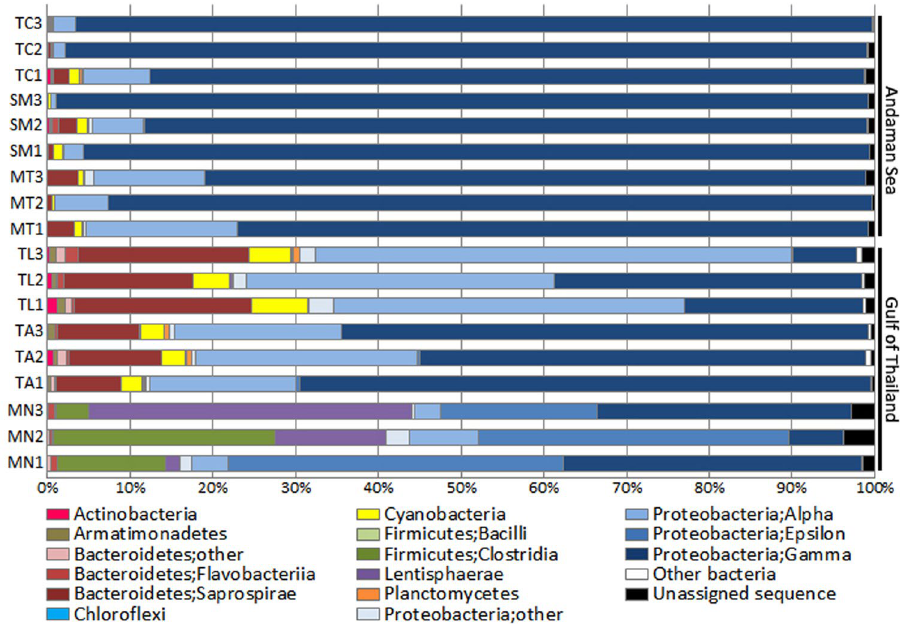
Figure 3. Taxonomic classification of OTUs at the phylum/class levels based on Greengenes database using QIIME